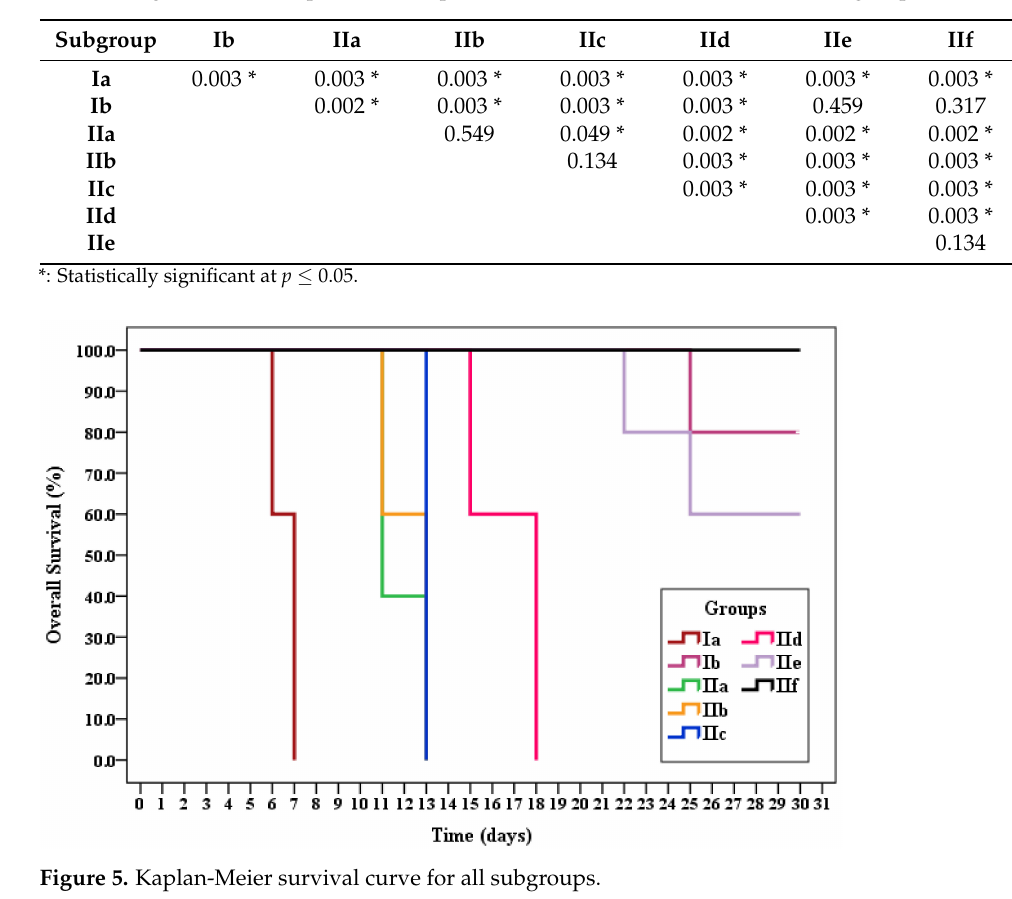
Table 3. Log rank survival pairwise comparison between the different studied subgroups.